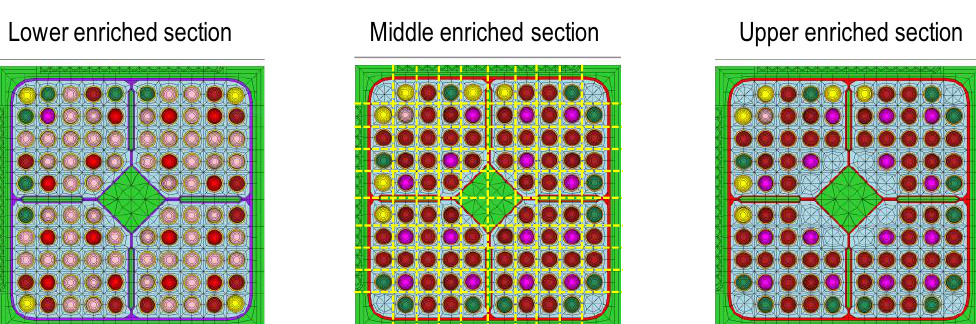
Figure 2. HELIOS models of the three enriched axial sections of the SVEA-96 Optima2 fuel assembly. Differ- ent colors of the pins represent different enrichments and different Gd 2 O 3 contents. The dashed yellow grid in the middle indicates the 10-by-10 pin cell lattice boundaries used for pin cell-wise cross section homogeniza- tion.